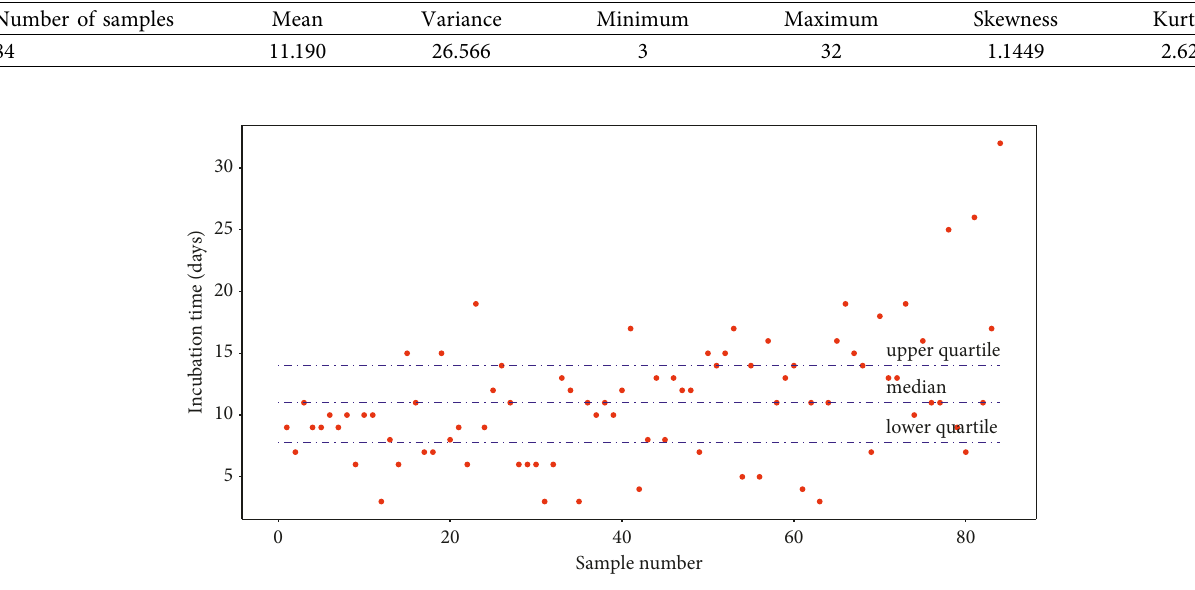
Table 1: Statistical characteristics of incubation time.